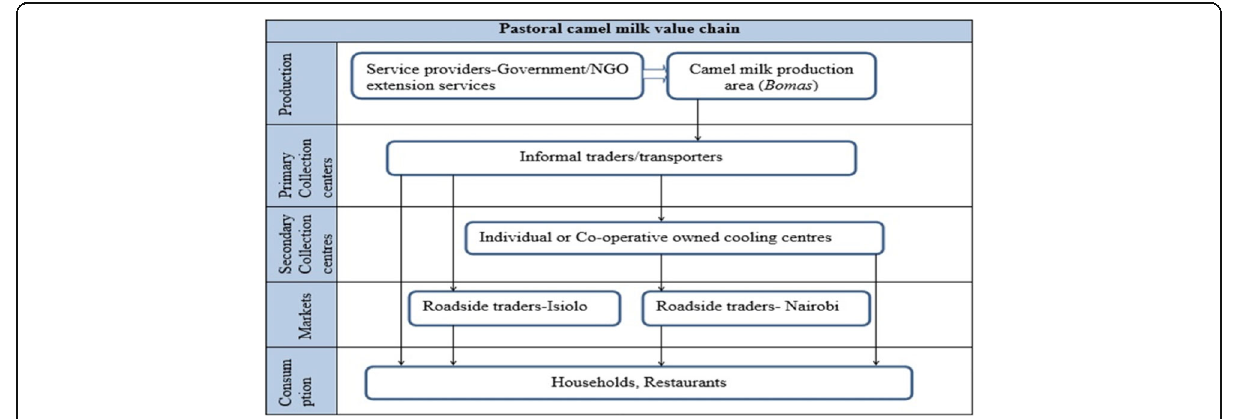
Figure 2 Pastoral dairy value chain for camel milk from Isiolo